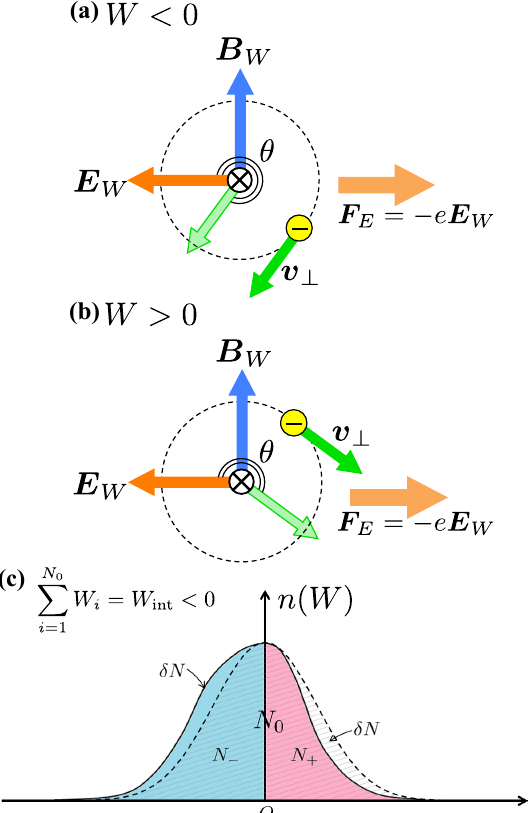
Fig. 1. Schematic illustration of the WPIA for whistler-mode wave- particle interactions. (a) and (b) represent the relation between the perpendicular component of the velocity of an energetic electron, and the wave electric ( E W ) and magnetic ( B W ) fields of whistler- mode waves propagating parallel to the background magnetic field direction for the cases of (a) W < 0 and (b) W > 0. (c) Distribu- tion of energetic electrons as a function of W for an example of a negative W int corresponding to wave generation. The total number of energetic electrons is N 0 , while N + and N − are the numbers of energetic electrons having positive and negative W ,